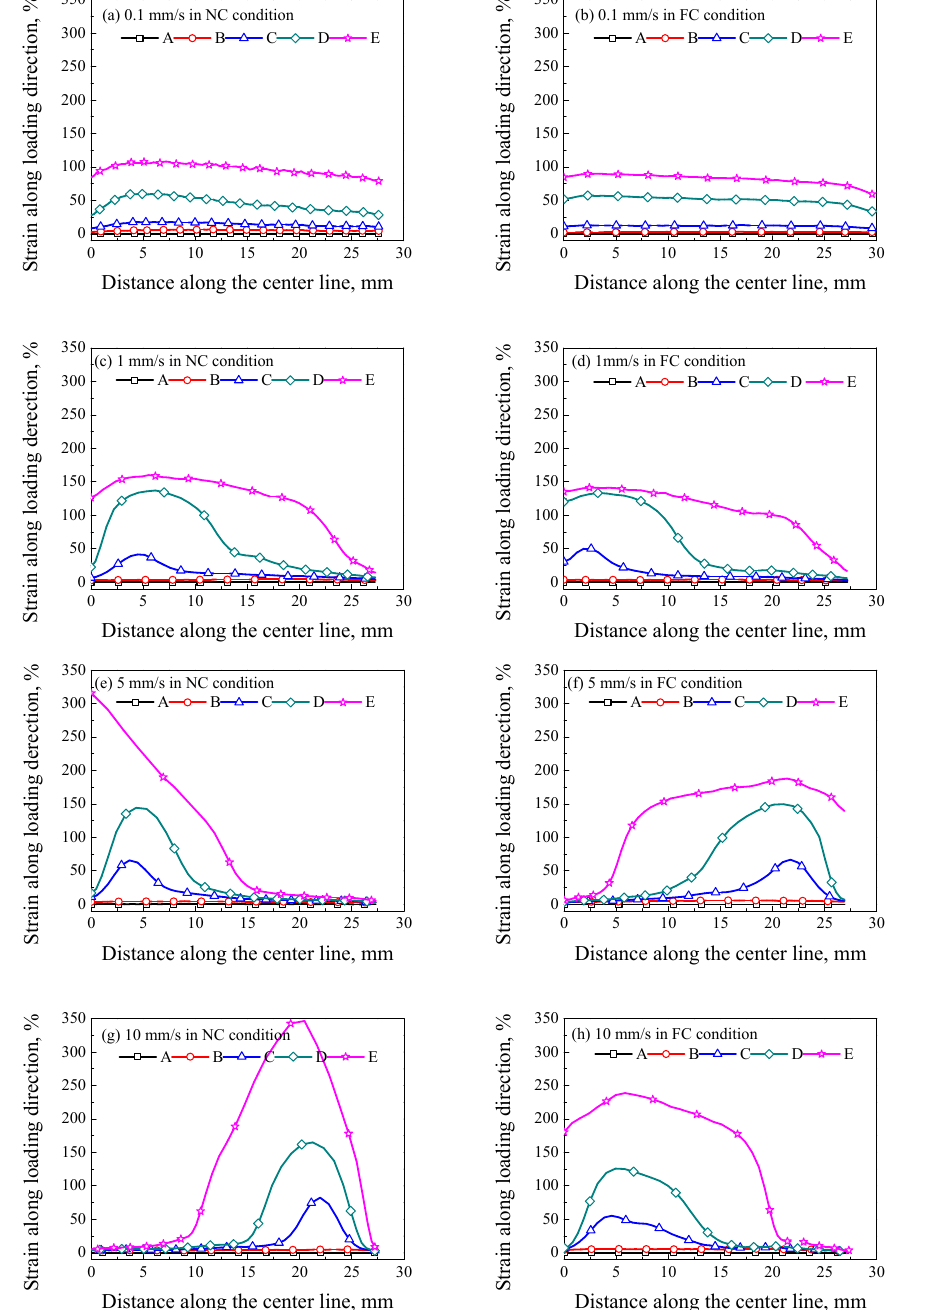
Figure 7. Strains along the center line of specimens at different loading rates of ( a ) 0.1 mm/s in the NC condition; ( b ) 0.1 mm/s in the FC condition; ( c ) 1 mm/s in the NC condition; ( d ) 1 mm/s in the FC condition; ( e ) 5 mm/s in the NC condition; ( f ) 5 mm/s in the FC condition; ( g ) 10 mm/s in the NC condition and ( h ) 10 mm/s in the FC condition.